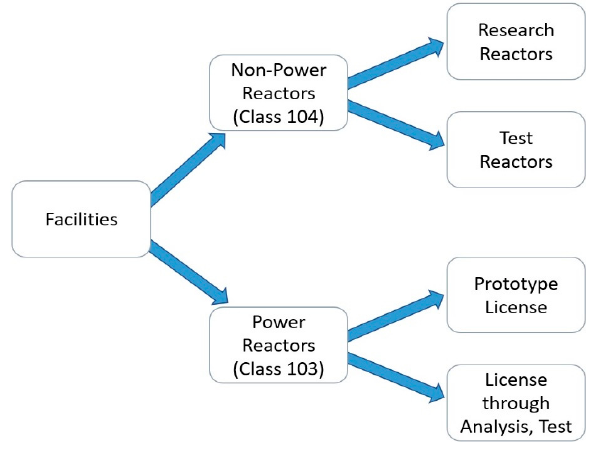
Figure 6. The U.S. NRC licensing structure.